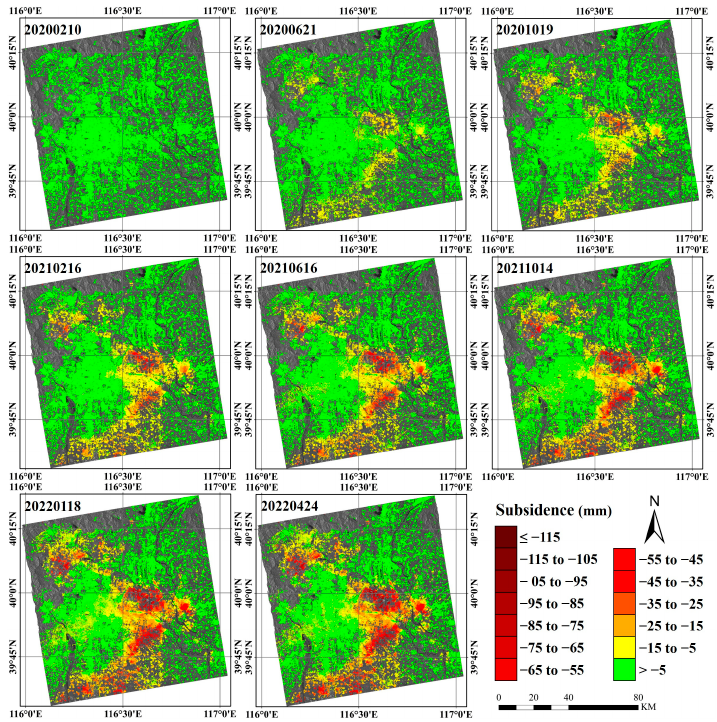
Figure 6. Time series of cumulative subsidence before the COVID-19 outbreak.